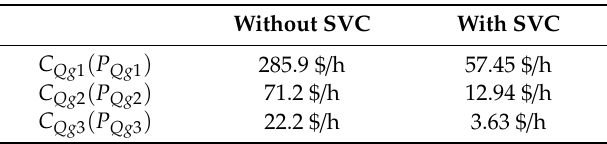
Table 3. Reactive power production cost of generator.